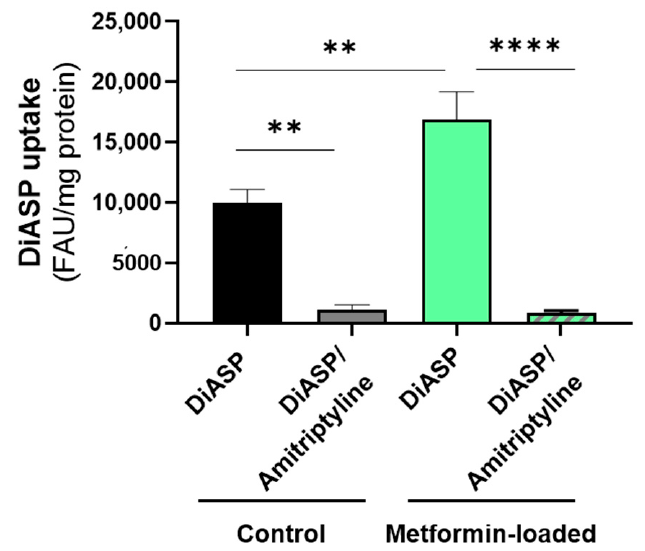
Figure 7. Effects of the reference OCT2 inhibitor amitriptyline on metformin-mediated trans - stimulation of DiASP uptake in HEK-OCT2 cells. HEK-OCT2 cells were either untreated (control) or treated by 10 mM metformin for 30 min at 37 °C. After washing, cells were incubated with 10 µM DiASP for 5 min at 37 °C, in the absence or presence of 100 µM amitriptyline. Accumulation of DiASP was finally determined by spectrofluorimetry and normalised to protein content. Data are expressed as DiASP-related fluorescence arbitrary unit (FAU)/mg protein and are the means ± SEM of at least three independent experiments performed in quadruplicate. **, p < 0.01 and ****, p < 0.0001.